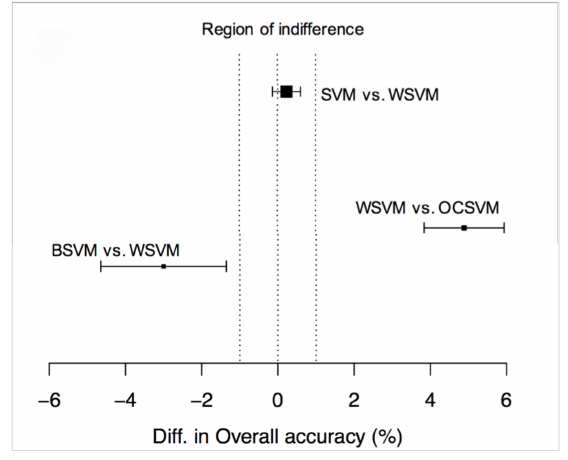
Figure 2. The overall accuracies of each method and their respective 95% confidence